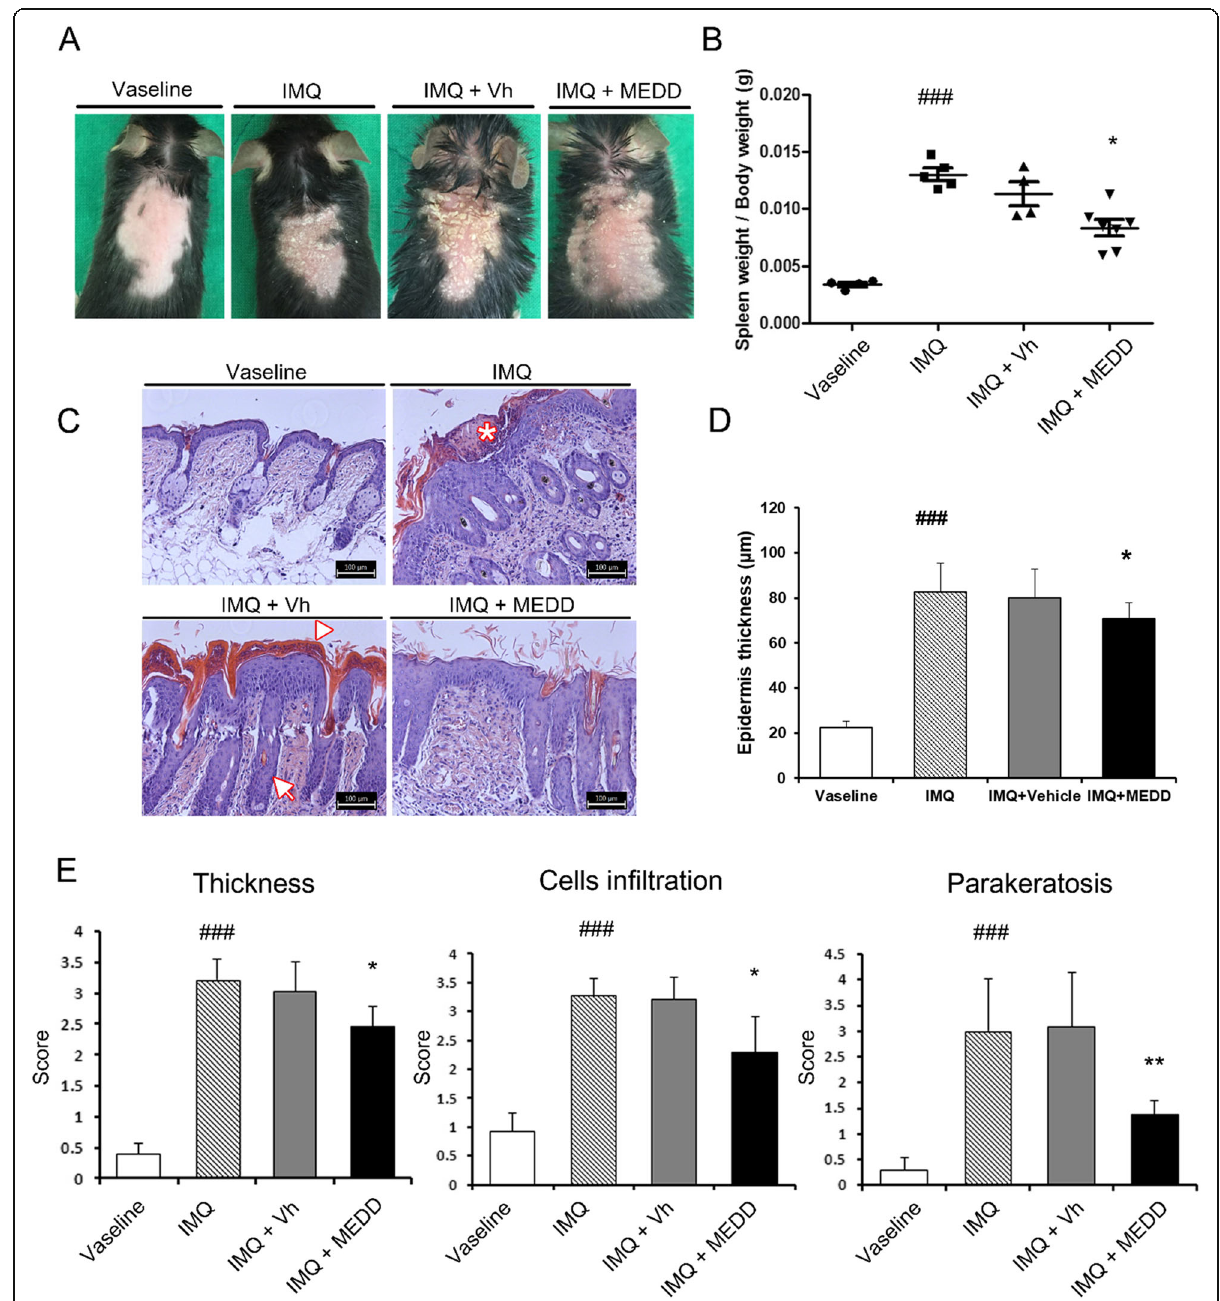
Fig. 1 Effects of MEDD on symptom severity in IMQ-induced psoriasis model mice. The dorsal skin of mice was treated with Vaseline, imiquimod (IMQ), IMQ and Vh or MEDD for 7 days, and the phenotype was observed the next day. a Representative macroscopic views of the dorsal skin of each group of mice. b Calculation of spleen weight per body weight for each treatment group. Each dot represents one mouse. c Hematoxylin and eosin staining of paraffin sections from the dorsal skin of each group of mice. Note: Munro ’ s abscess (asterisk), parakeratosis (arrowhead), and rete ridge (arrow). Scale bar: 100 μ m d Microscopic measurement of epidermal thickness ( μ m) of dorsal skin. e Individual histological scoring of thickness, immune cell infiltration, and parakeratosis in the skin. b , d , e These results represent mean ± S.D. of four independent experiments. a , c The photograph is representative of four independent experiments. Statistical analysis was performed using Student ’ s t -test. * p < 0.05; ** p < 0.01, compared with mice in the IMQ- and vehicle-treated group; ###, p < 0.001, compared with Vaseline control mice; IMQ, imiquimod; Vh, Vehicle; MEDD, methanol extract of Dictamnus dasycarpus root